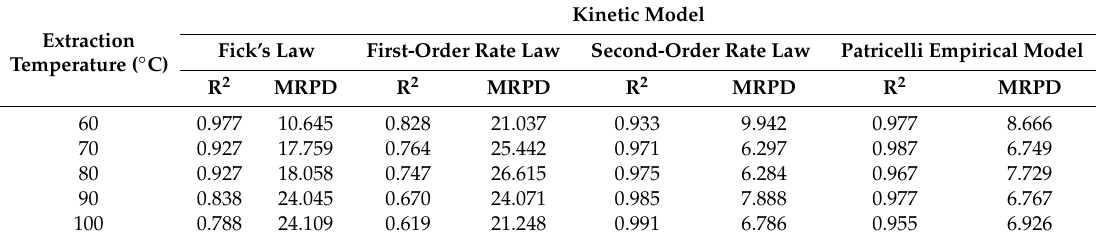
Table 2. Statistical parameters of the kinetic modelling for MAE-brine of lipids from Nannochloropsis sp.